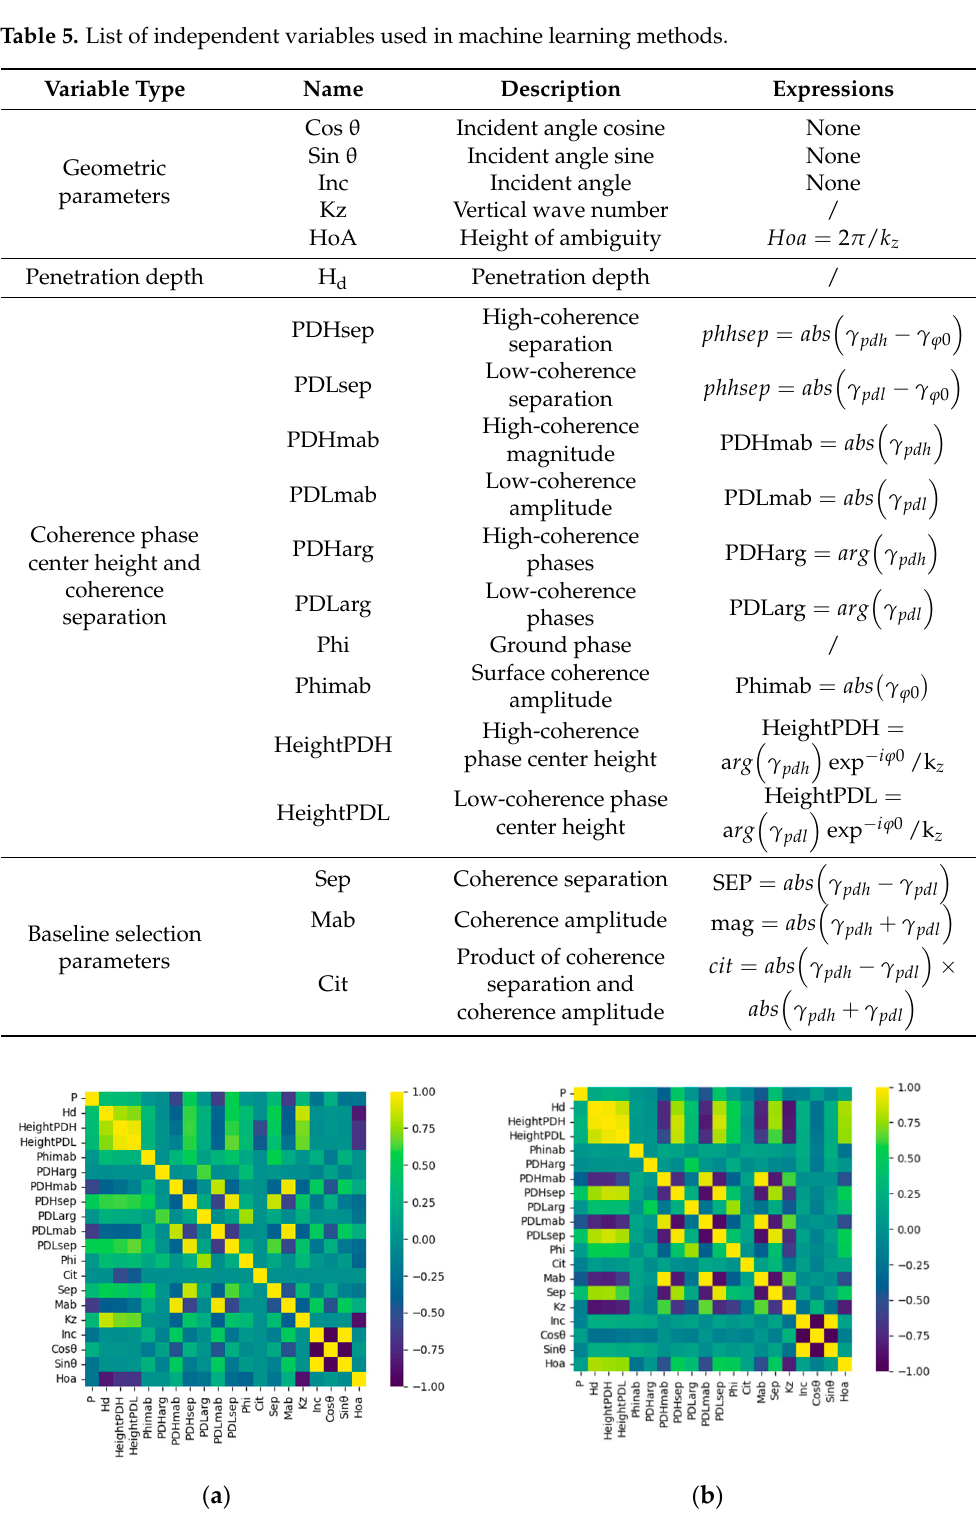
Figure 12. Heat maps showing the independent variable Pearson correlation coefficient between variable pairs for the ( a ) Lope and ( b ) Pongara test areas. To ensure consistency with the sample data in reported in the above sections, 4239 and 3068 samples were used model training in the Lope and Pongara regions, respectively; the scatter of the independent validation samples is shown in Figure 13. During construction of the random forest model, the model parameters were optimized twice, first using